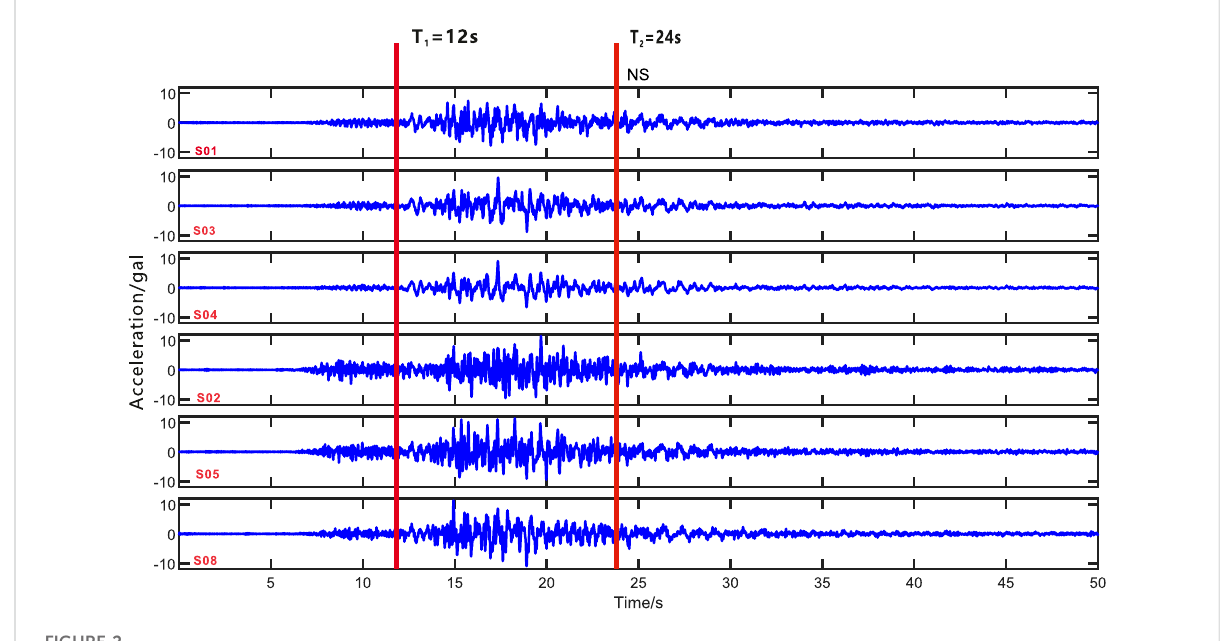
FIGURE 2 Schematic diagram of time window interception (NS component of the Luxian earthquake).